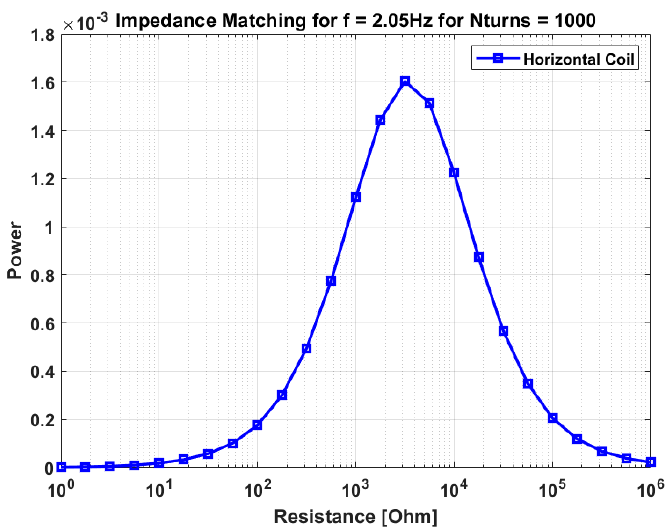
Figure 8. Impedance matching for horizontal coil of 1000 turns on L = 10 cm tank for frequency = 2.05 Hz.